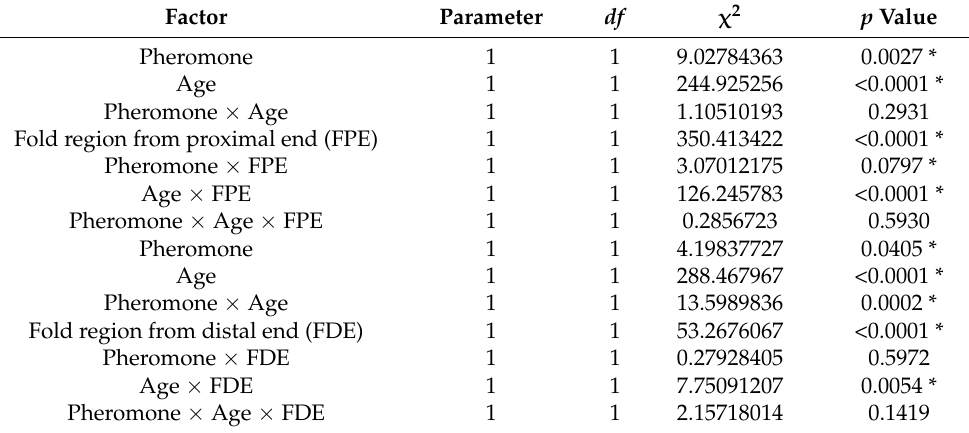
Table 8. The results of ordinary logistic regression analysis on the effects of pheromone emitted from nymph or adult and adult age on sperm storage in the desert locust Schistocerca gregaria , when sperm accumulation was counted from the proximal end or distal end of the folded seminal vesicle. Factor Parameter df χ 2 p Value